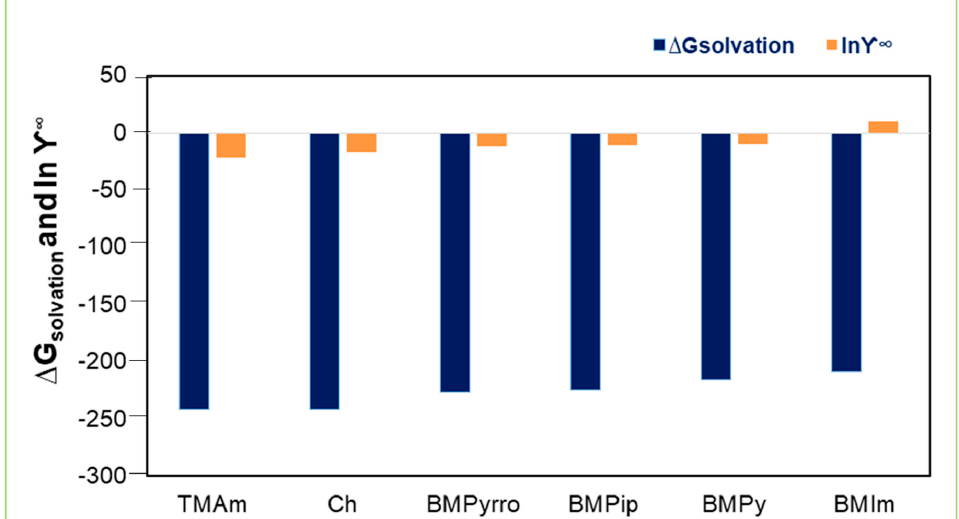
Figure 7. Solvation energies for ILs with the best selected anion.